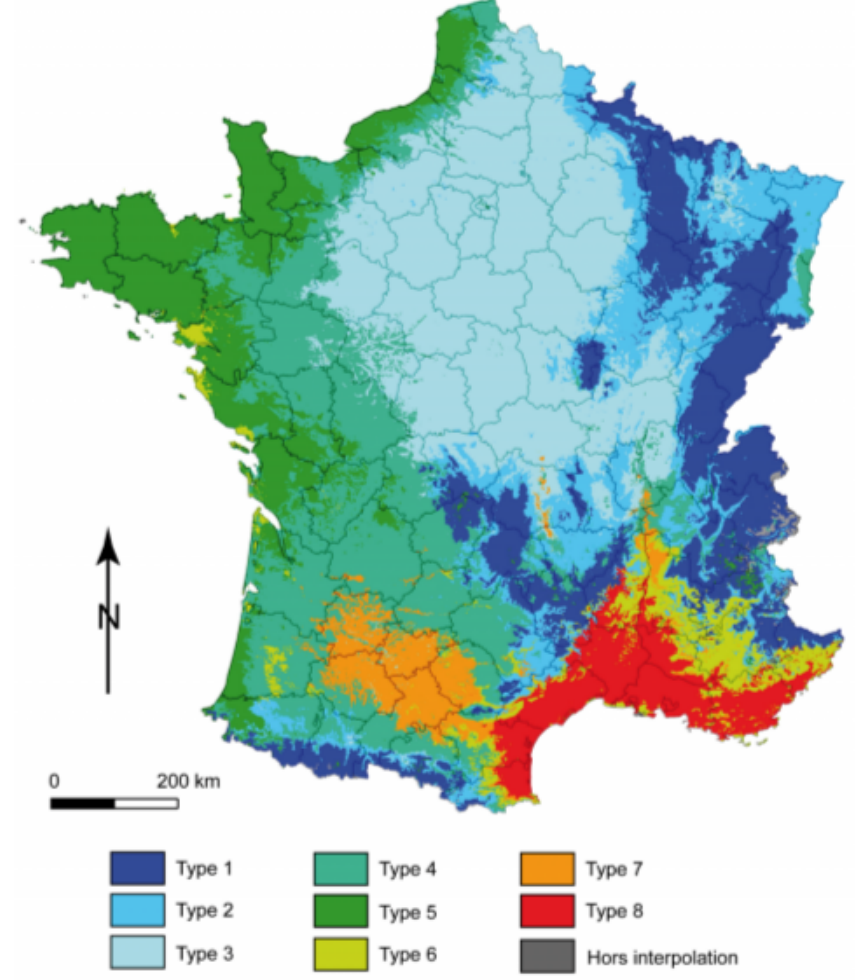
Figure 2. Eco-climatic area map for the study area from